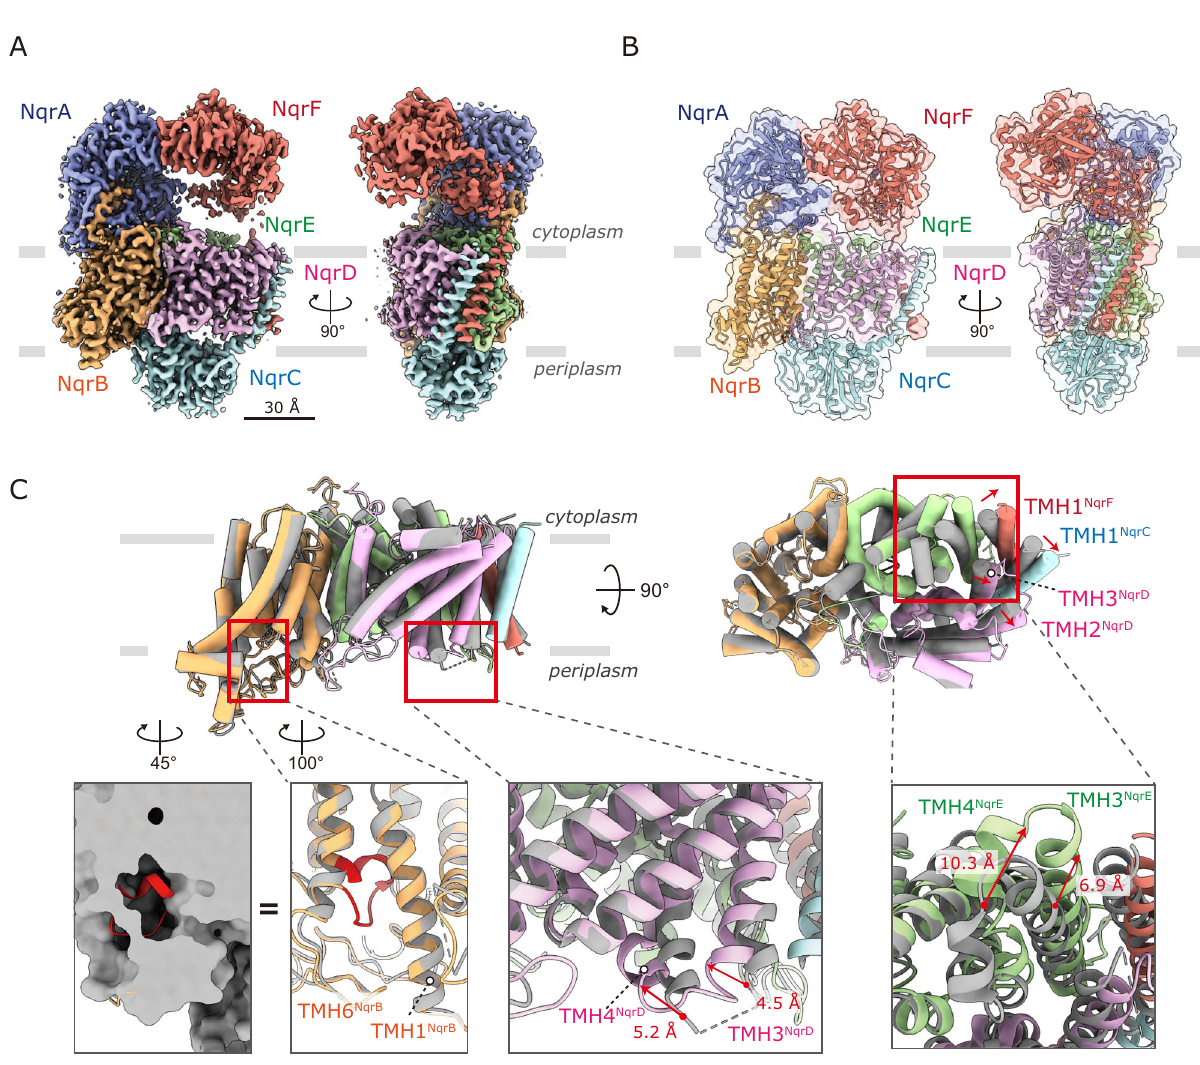
Fig. 1 Overall structure of V. cholerae Na + -NQR. The density map A and the atomic model B of Na + -NQR, showing the six subunits NqrA – F. The density map and the atomic model are represented as semi-transparent surface and cartoon, respectively. The hydrophilic NqrA ( blue ) contains no TMH. NqrC ( pale blue ) and NqrF ( red ) are hydrophilic proteins, each anchored by a single TMH. The NqrB ( yellow ), NqrD ( pink ), and NqrE ( green ) subunits are integral membrane proteins. The membrane plane is indicated by gray lines. C Overlay of cryo-EM structure of the membrane domain ( color ) with the crystallographic structure ( gray, 16 ). NqrB, NqrC, NqrD, NqrE, and NqrF subunits have 10, 1, 6, 6, and 1 TMHs, respectively. TMHs are shown as cylinder models. The membrane domain contains a total of 24 TMHs. In the leftmost inset, the membrane interior loop (Gly266 – Ser276) in the cryo-EM structure is indicated in red . The hydrophilic domain of each subunit, which protrudes from the membrane, has been deleted for clarity. TMHs are